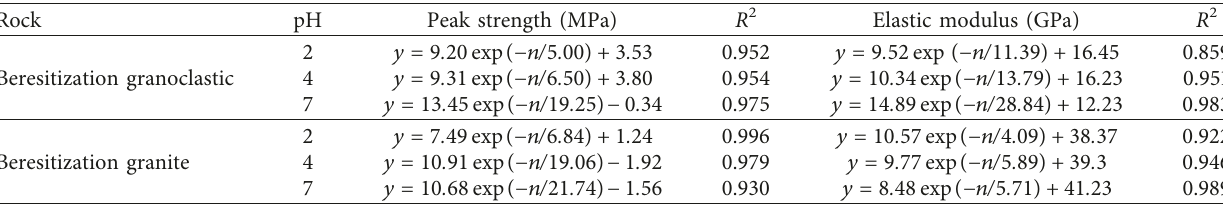
Table 6: The fitting expression between mechanics parameters and